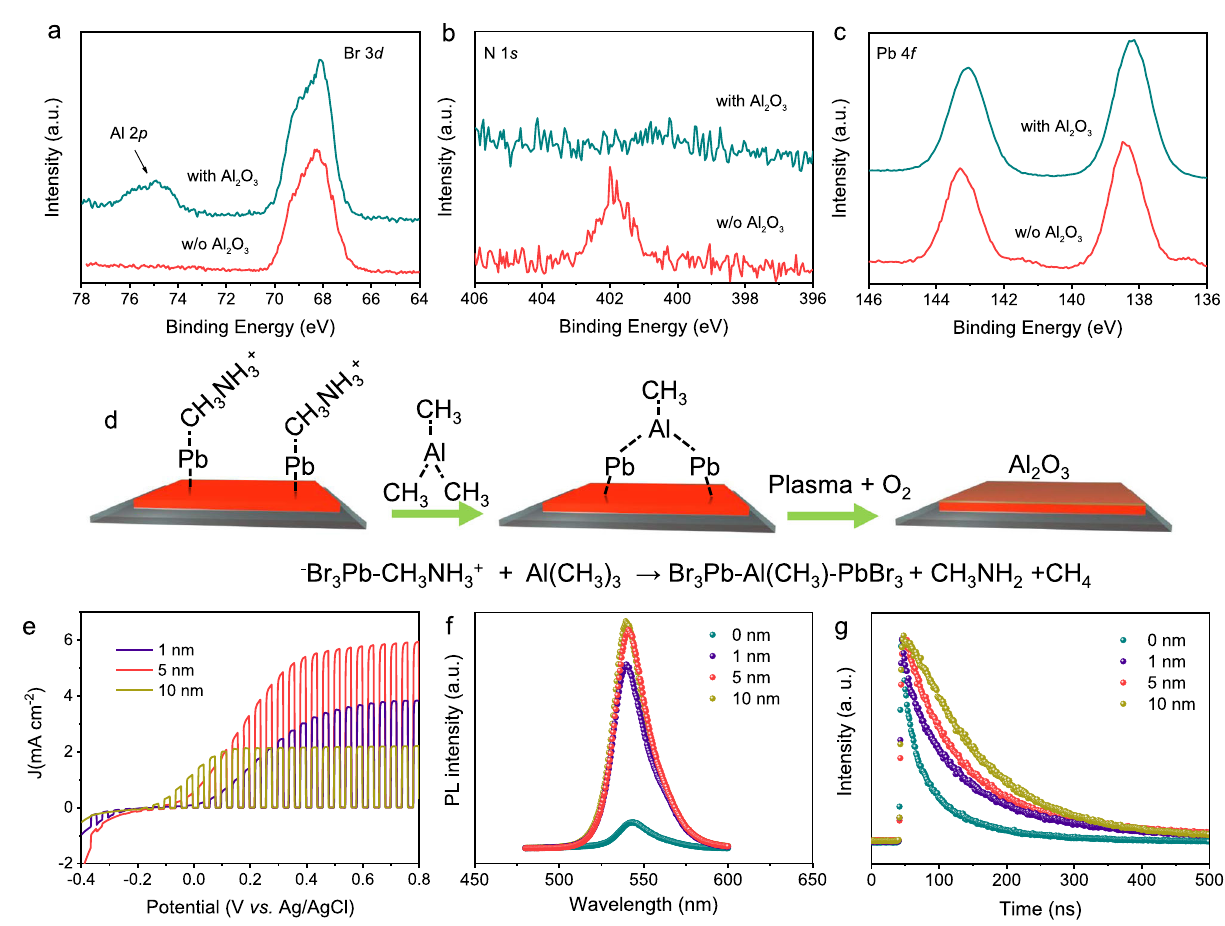
Fig. 2 Al 2 O 3 passivation effect investigation. XPS spectra of pristine MAPbBr 3 SCTF and MAPbBr 3 SCTF/Al 2 O 3 : Al 2 p and Br 3 d ( a ), N 1 s ( b ), and Pb 4 f ( c ). d Proposed passivation mechanism of Al 2 O 3 on the MAPbBr 3 SCTF surface. e PEC behavior of MAPbBr 3 SCTF/Al 2 O 3 -based photoelectrodes as a function of Al 2 O 3 deposition thickness. Al 2 O 3 -thickness-dependent steady-state photoluminescence (PL) spectra ( f ) and time-resolved PL decay curves ( g